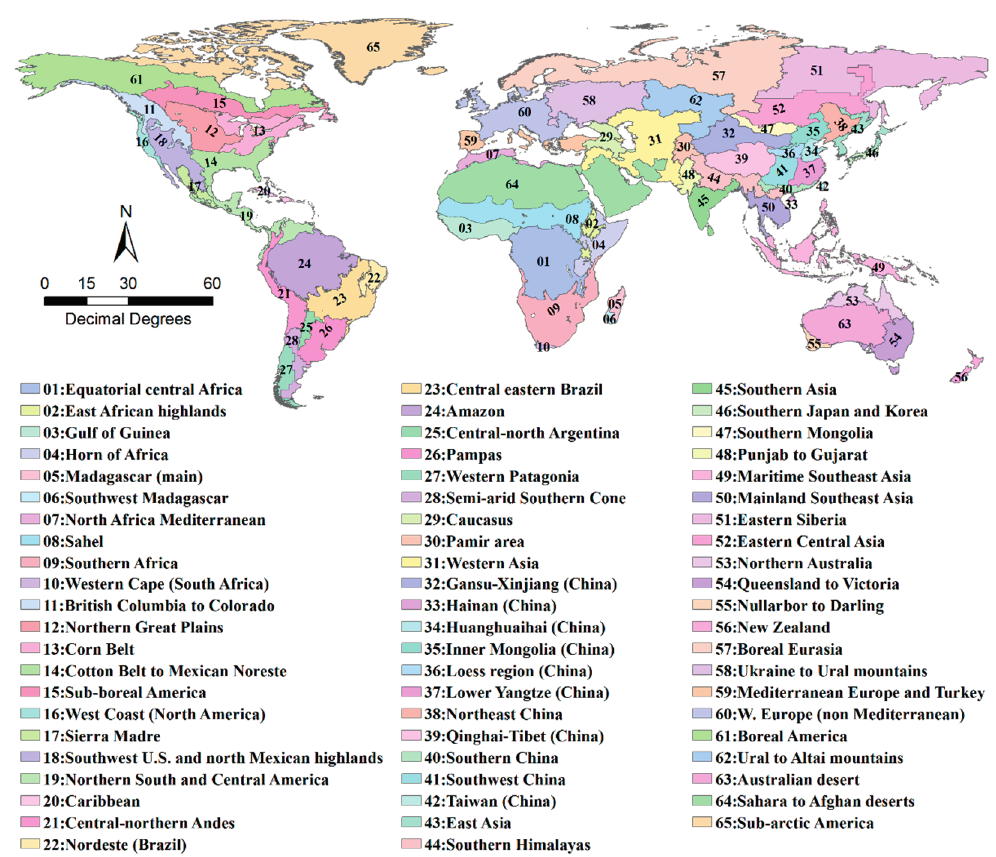
Figure 2. Sixty-five Monitoring and Reporting Units of the CropWatch system.